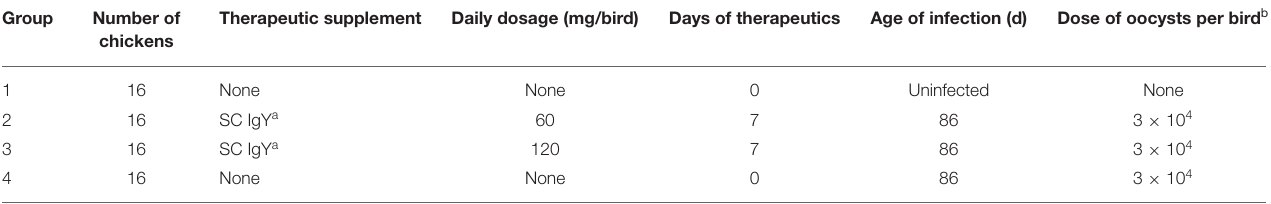
TABLE 1 | Group and experimental design. Group Number of Therapeutic supplement Daily dosage chickens